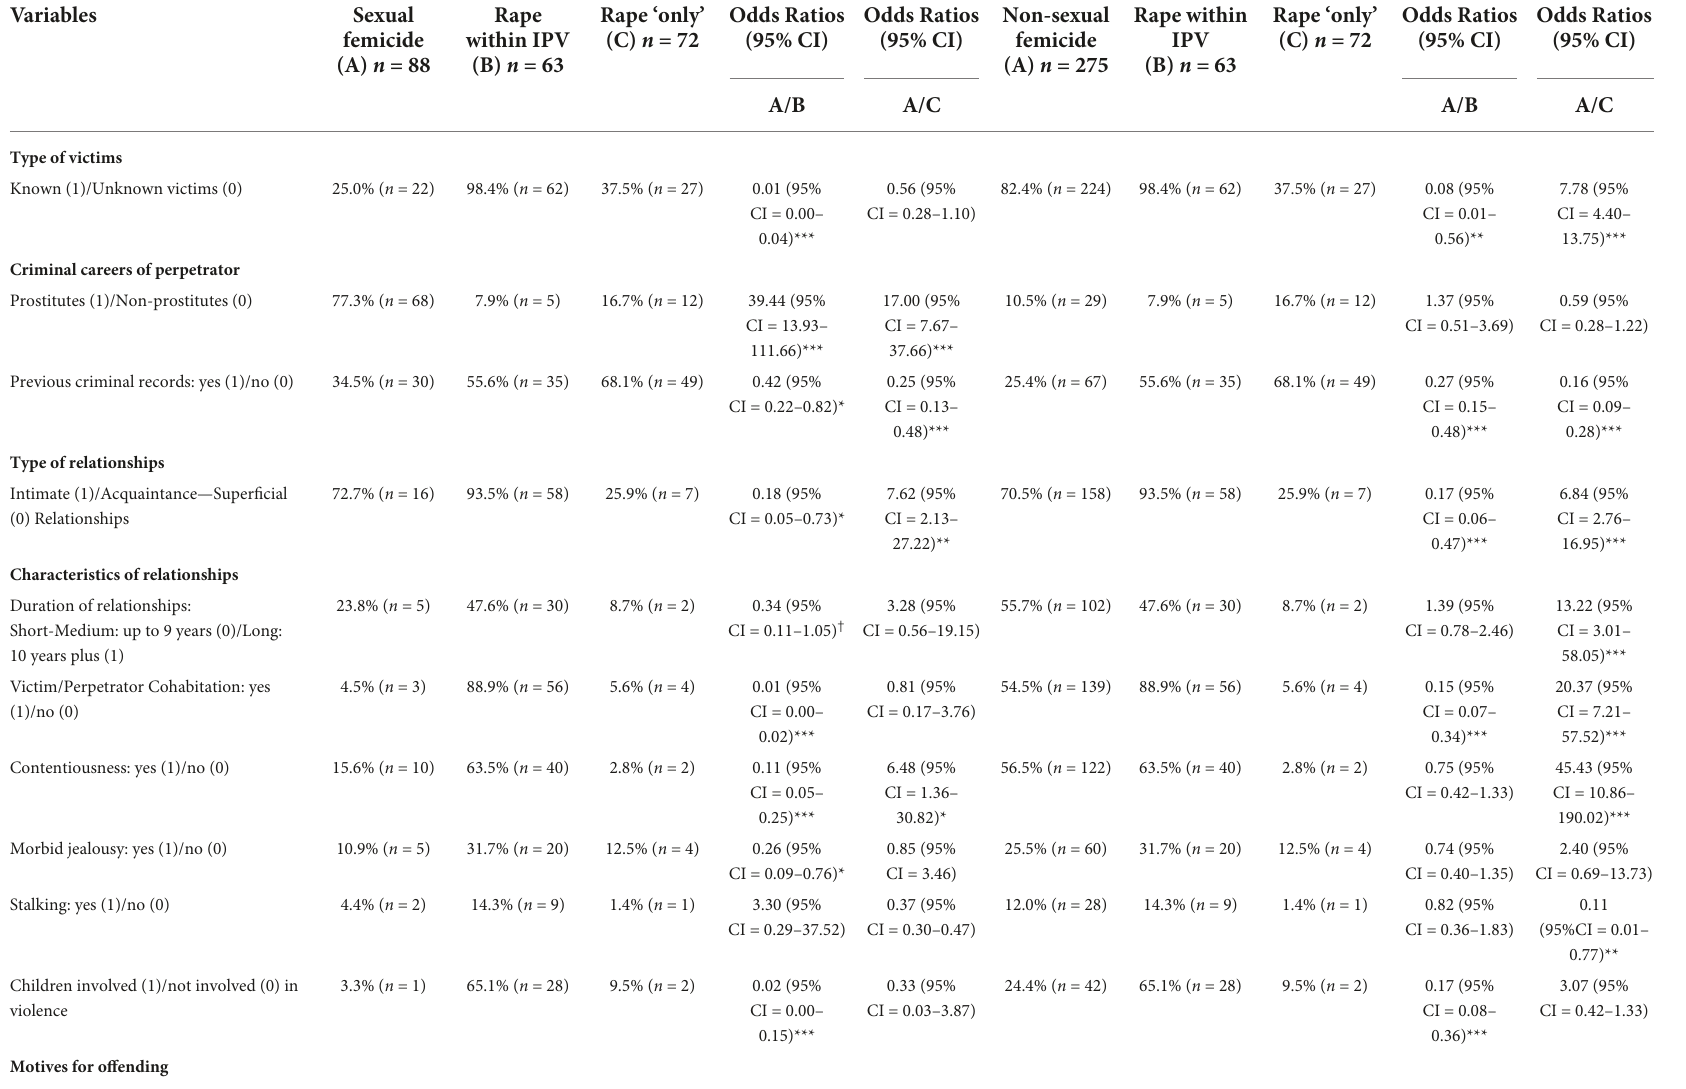
TABLE 5 Comparisons of sexual femicide and non-sexual femicide with rape within IPV and rape ‘only.’